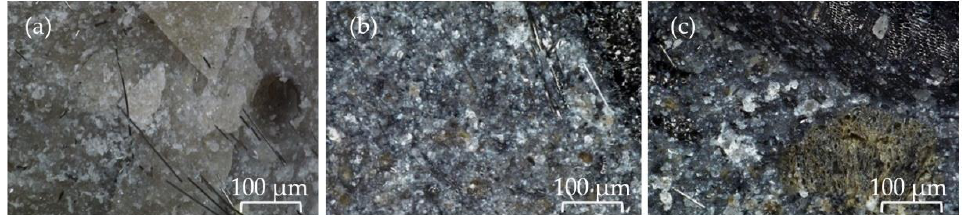
Figure 6. SEM images of geopolymer with an FA4 content of 0, 0.5, and 0.75 max, marked as ( a ), ( b ), and ( c ), respectively.